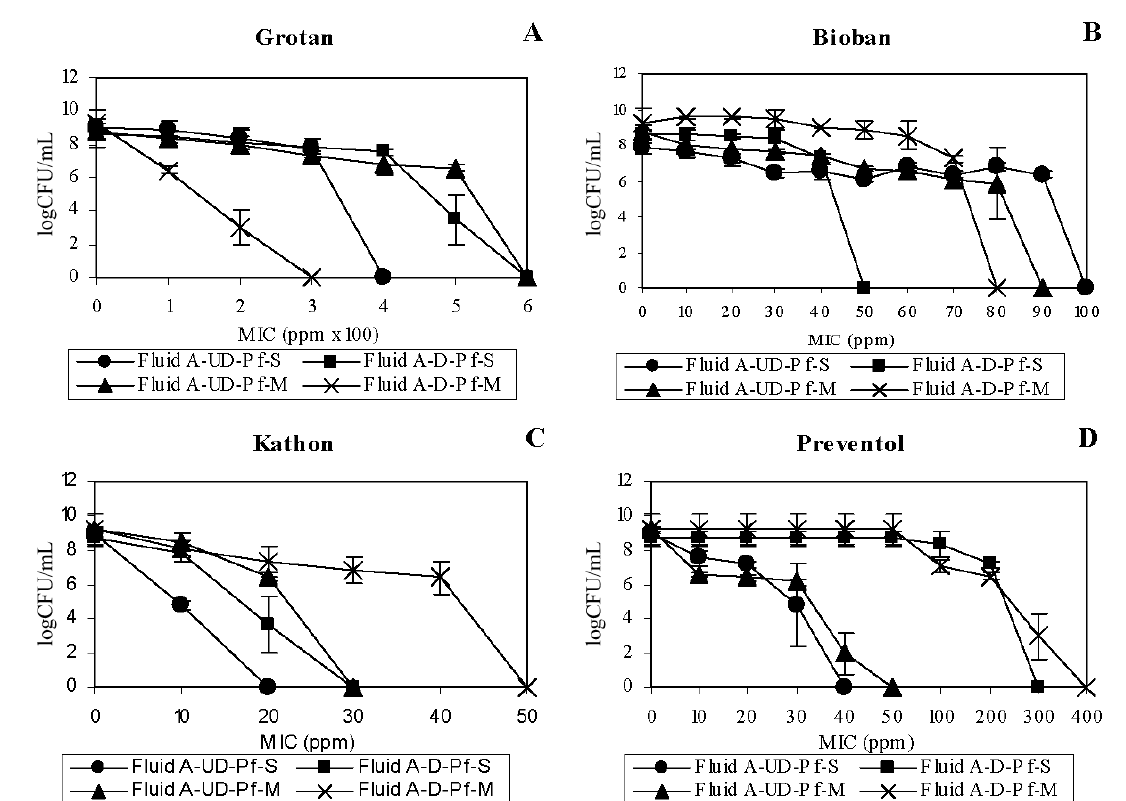
Figure 4. Effect of fluid dialysis on biocidal efficacy toward P. fluorescens . Two forms of Fluid A (undialyzed and dialyzed) were used to compare the biocidal activities of Grotan (Panel A ), Bioban (Panel B ), Kathon (Panel C ) or Preventol (Panel D ) toward P. fluorescens . The activities were compared in terms of mean minimum inhibitory concentration (MIC) in the given fluid matrix simulated with either a single culture (pure) suspension or mixed culture suspension (1:1 ratio with M. immunogenum ) of P. fluorescens . The test organism was exposed to the varying levels of biocides for 15 min each in the two MWF matrices. Fluid dialysis was meant to remove the native